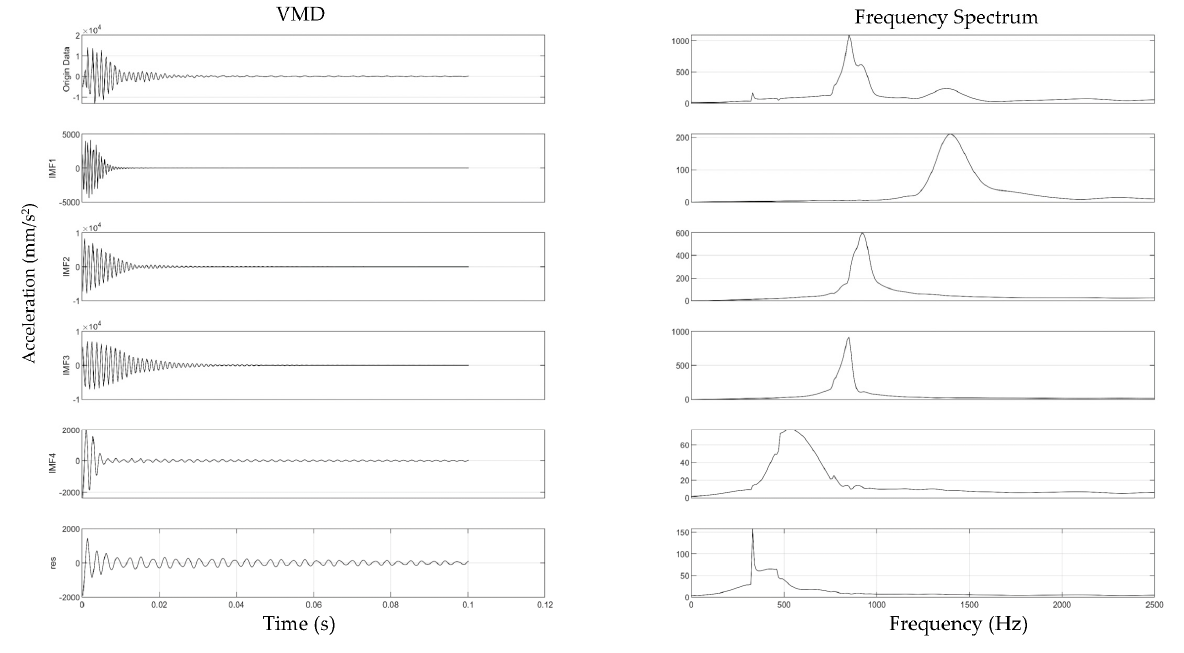
Figure 17. Acceleration response VMD decomposition (one bolt loosened to 300 N).